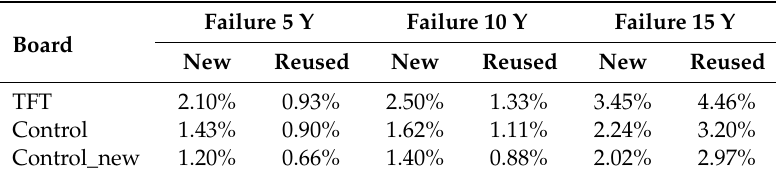
Table 4. Estimated cumulative failure probability using new components or used components in the three test boards. Table 5. Failure rate and cost of some components of the Control_new board.